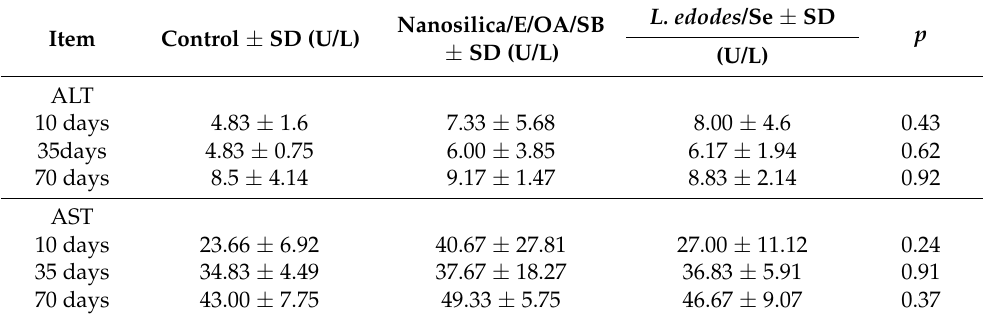
Table 6. Effect of nanosilica/E/OA/SB and L. edodes mycelium on the level of liver enzymes: ALT and AST ( n = 6).